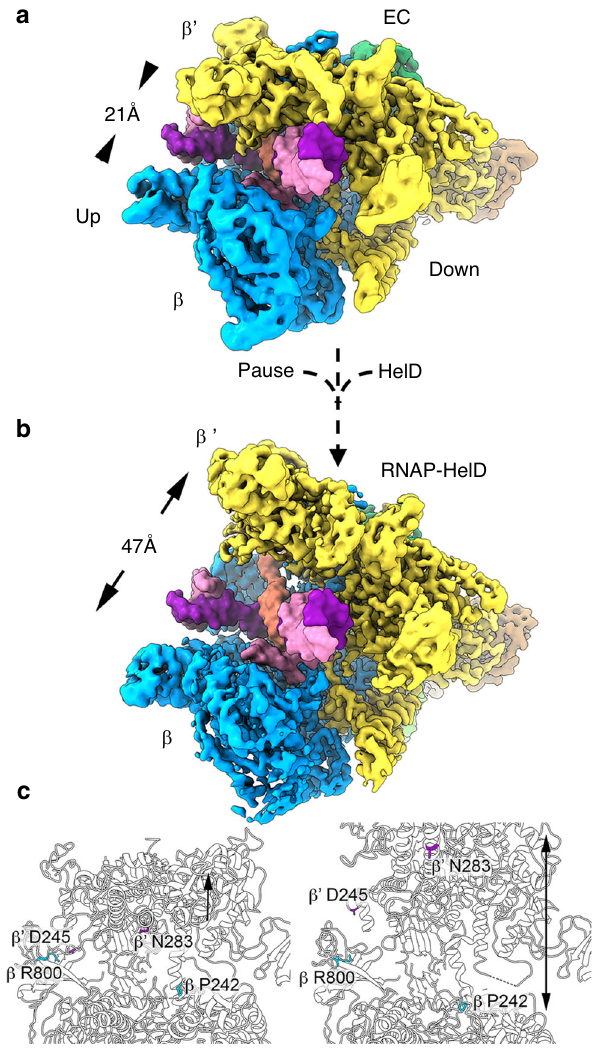
Fig. 4 HelD-induced conformational change in RNAP. a , b Cryo-EM electron density maps ( α 2 ββω subunits only) of RNAP EC ( a ) and RNAP – HelD complex ( b ). HelD density has been removed for clarity, and nucleic acids from the E. coli EC (PDB ID 6ALF) superimposed over the B. subtilis EC nucleic acids as a visual aid for the scale of conformational changes that occur in the primary DNA-binding and RNA exit channels upon binding HelD. Nucleic acids are coloured the same as in Fig. 1. The longer RNA from the E. coli EC helps illustrate the increase in aperture of the RNA exit channel. c left side EC, right side RNAP-HelD complex with HelD removed for clarity, with β (cyan) and β ʹ (purple) residues shown to illustrate the change in aperture of the RNA exit channel β R800 and β ʹ D245 and DNA binding channel β P242 and β ʹ N283. Black arrow in left panel indicates the region of the β ʹ clamp that is contacted by the HelD clamp arm and the double-ended arrow in the right panel indicates the movement of subunits away from each other on HelD